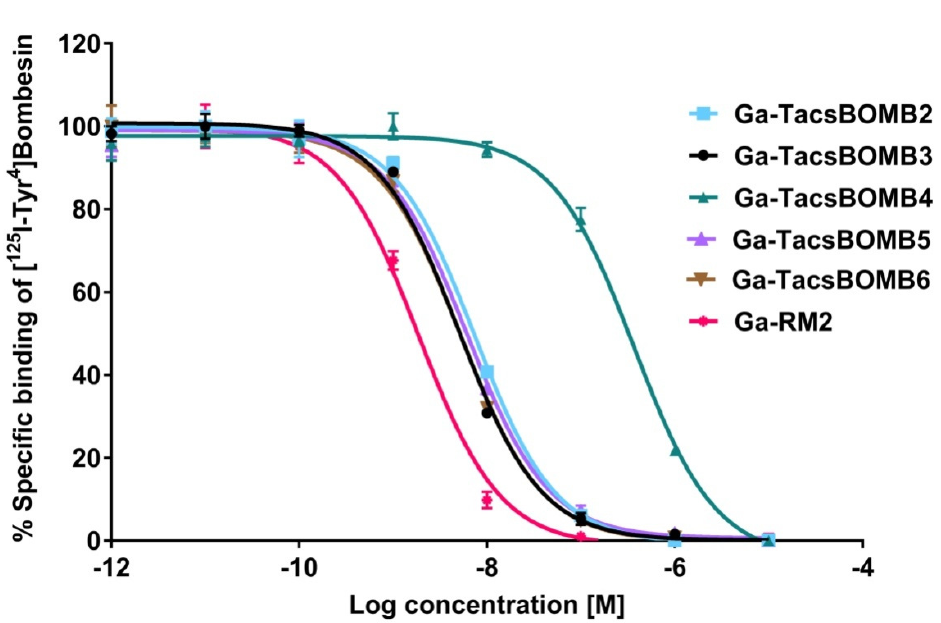
Figure 2. Displacement curves of [ 125 I-Tyr 4 ]Bombesin by Ga-TacsBOMB2, Ga-TacsBOMB3, Ga- TacsBOMB4, Ga-TacsBOMB5, Ga-TacsBOMB6, and Ga-RM2 generated using GRPR-expressing PC-3 cells. Error bars indicate standard deviation.